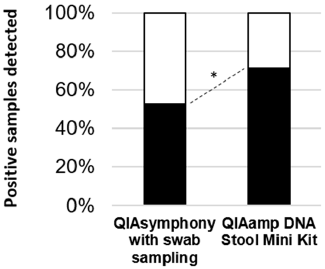
Figure 1. Comparison of DNA extraction methods using the qPCR assay developed by Poirier et al. Positive samples detected using the qPCR published by Poirier et al. [12] are represented in black and positive samples not detected are in white. *: p < 0.05.